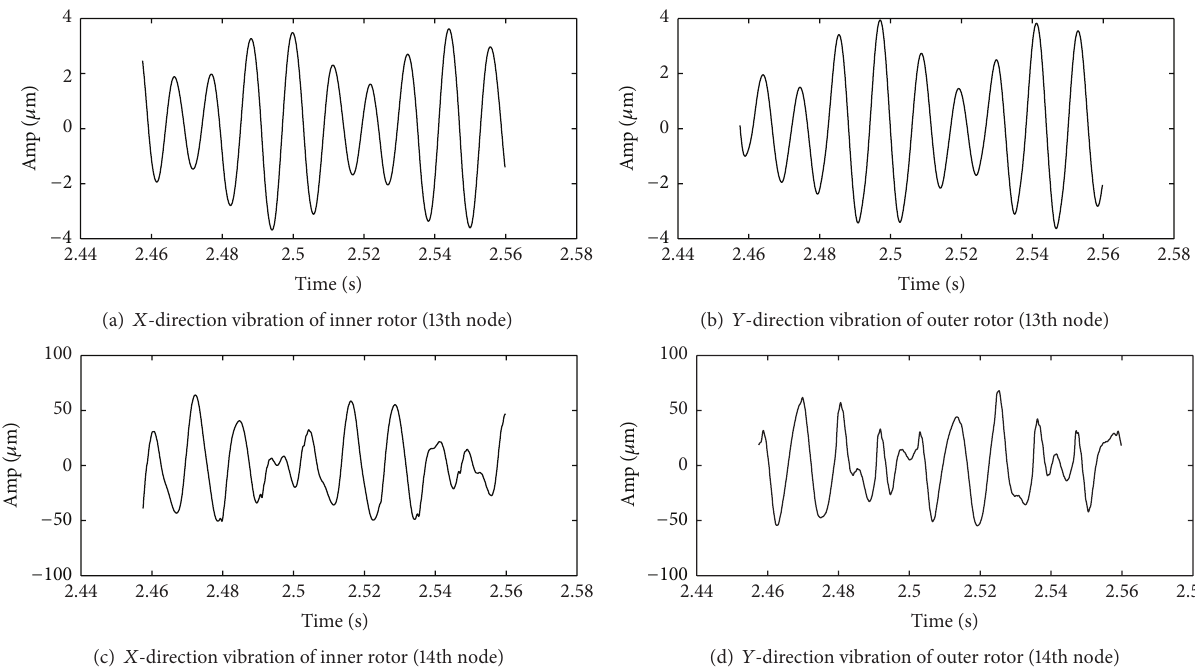
Figure 6: The vibration displacement waveform of inner and outer rotors (rubbing location: outer rotor disc).